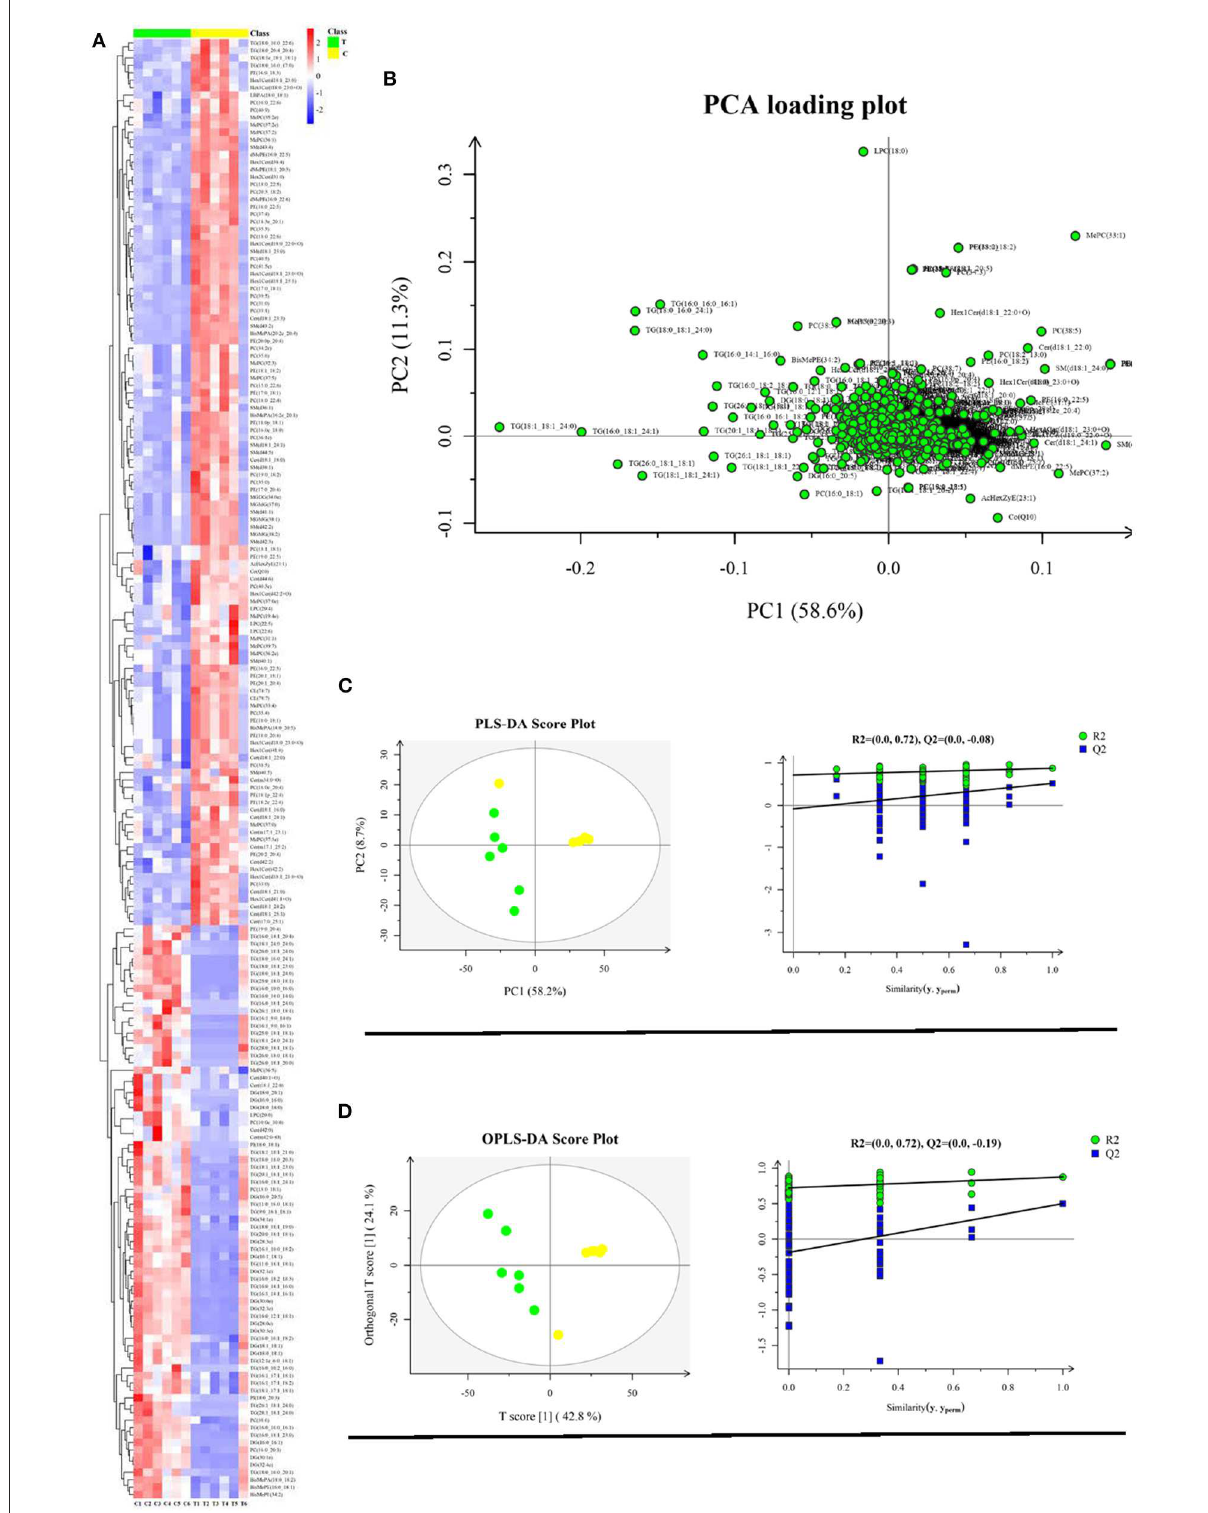
FIGURE3 Liver lipidome profile analysis (control group vs. treatment group) ( n = 6). (A) Hierarchical clustering analysis for the significantly different lipid; (B) Lipidome profile principal component analysis (PCA); (C) PLS-DA score plots and PLS-DA corresponding validation plots; (D) OPLS-DA score plots and OPLS-DA corresponding validation plots. Yellow plot represents control group ( n = 6); green plot represents treatment group ( n =